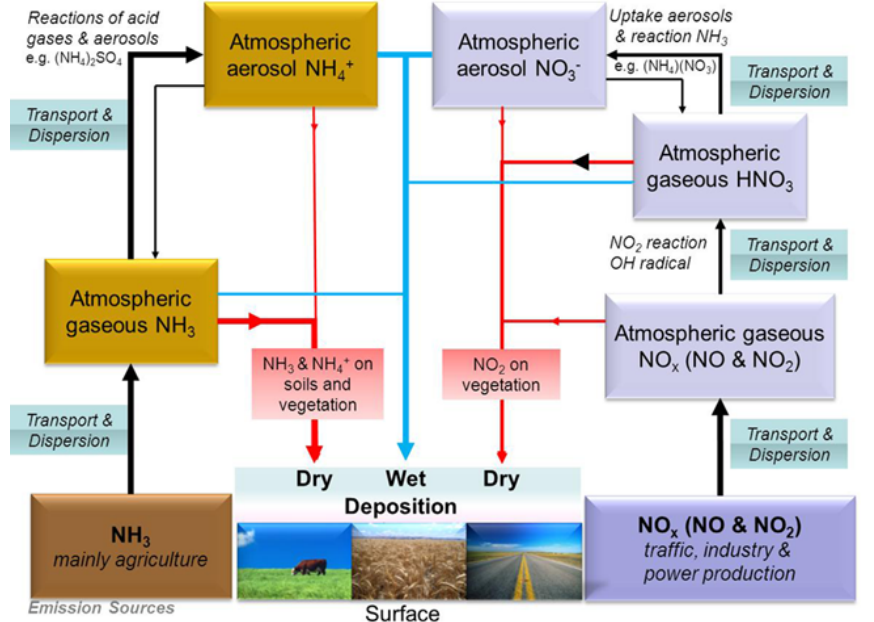
Fig. 1. A sketch which illustrates the various pathways of reactive nitrogen compounds in the atmosphere. The left side of the figure illustrates the atmospheric pathways of NH x (gas phase ammonia (NH 3 ) and aerosol phase ammonium (NH + illustrates the pathway of nitrogen oxides (NO y ) compounds in the atmosphere (NO x = NO + NO 2 and reaction products). The sketch is a modified version of the figure in Hertel et al. (2006). Reservoir compounds nitrous acid (HONO), peroxy nitric acid (HO 2 NO 2 ), PAN (CH 3 C(O)OONO 2 ) and PAN-like species like isoprene nitrates as well as nitrate (NO 3 ) and dinitrogen pentoxide (N 2 O 5 ) radicals have been disregarded in the sketch for